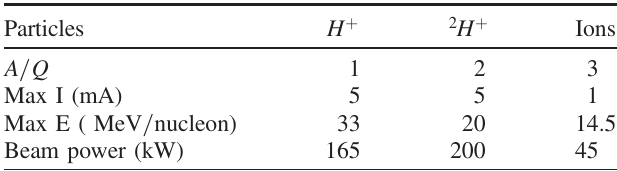
TABLE I. Beam parameters at SPIRAL2 SC linac.